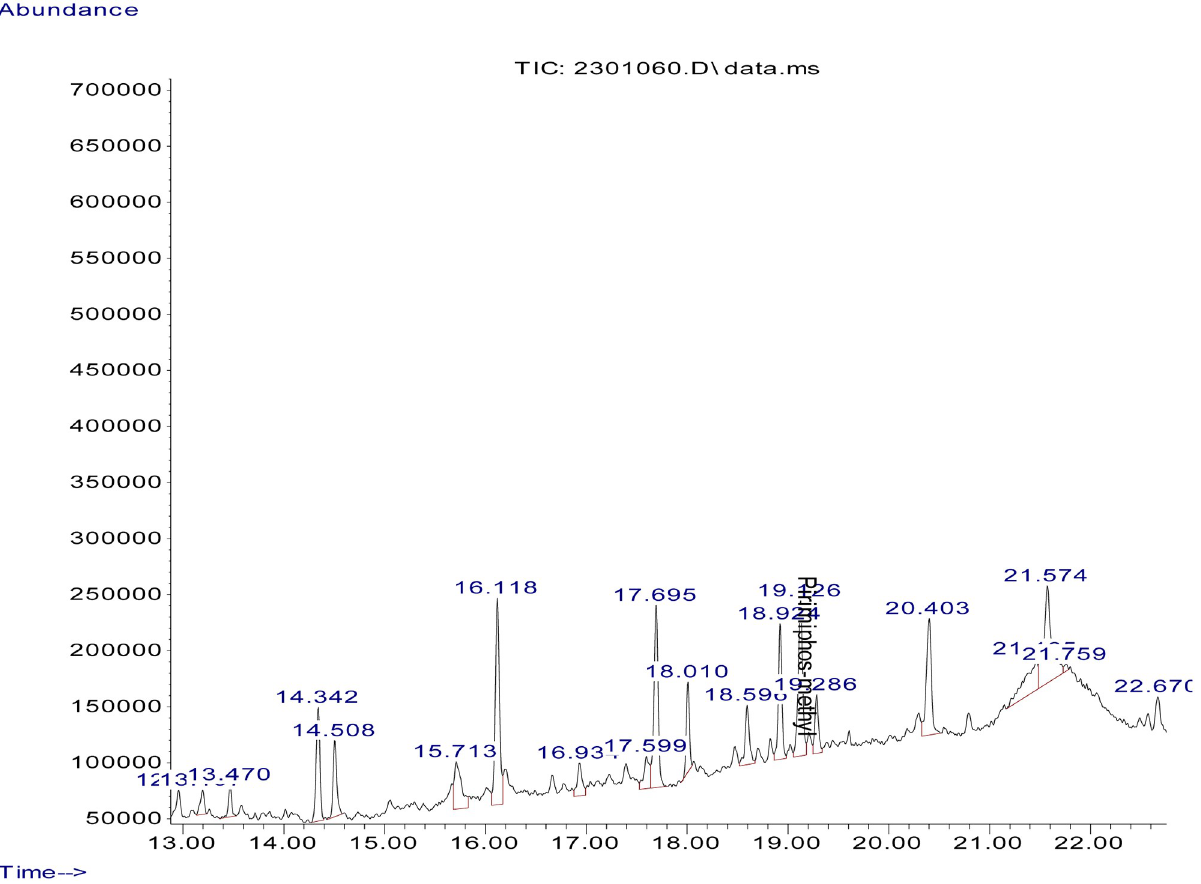
Fig 5. Chromatogram of pirimiphos-methyl in onion.